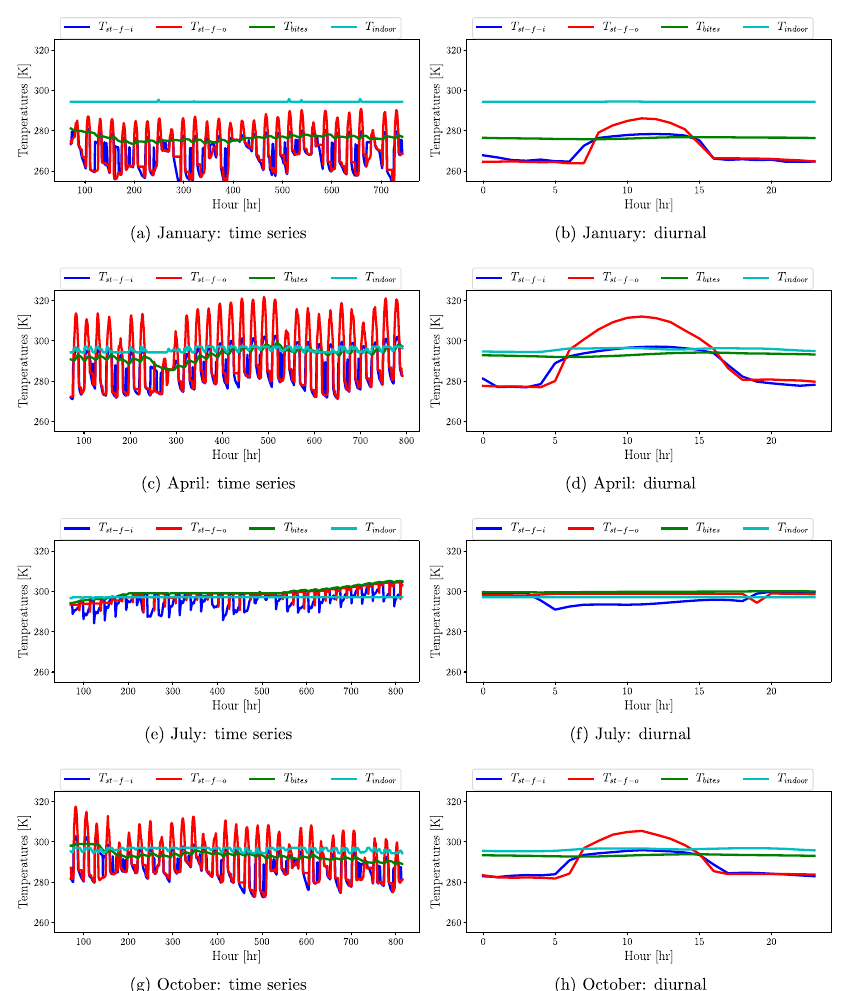
Figure A4. System temperatures: time series ( a , c , e , g ) and diurnal ( b , d , f , h ) variation of working fluid temperature into and out of the solar thermal collector T st of BITES T bites , and indoor temperature T indoor , all in [K]; diurnal variation is shown for the mean values at every diurnal hour.